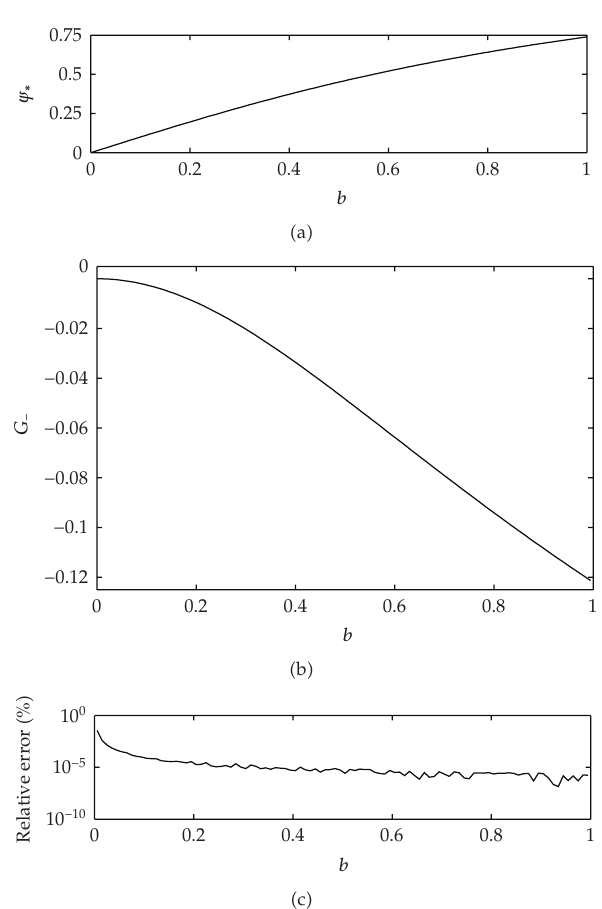
Figure 7: The values for ψ (cid:14) as a function of b (cid:2) a (cid:3) and the series G − from (cid:2) 3.19b (cid:3) together with the relative error when compared to the integral from (cid:2) 3.25a (cid:3) (cid:2)(cid:2) b (cid:3) , (cid:2) c (cid:3)(cid:3)